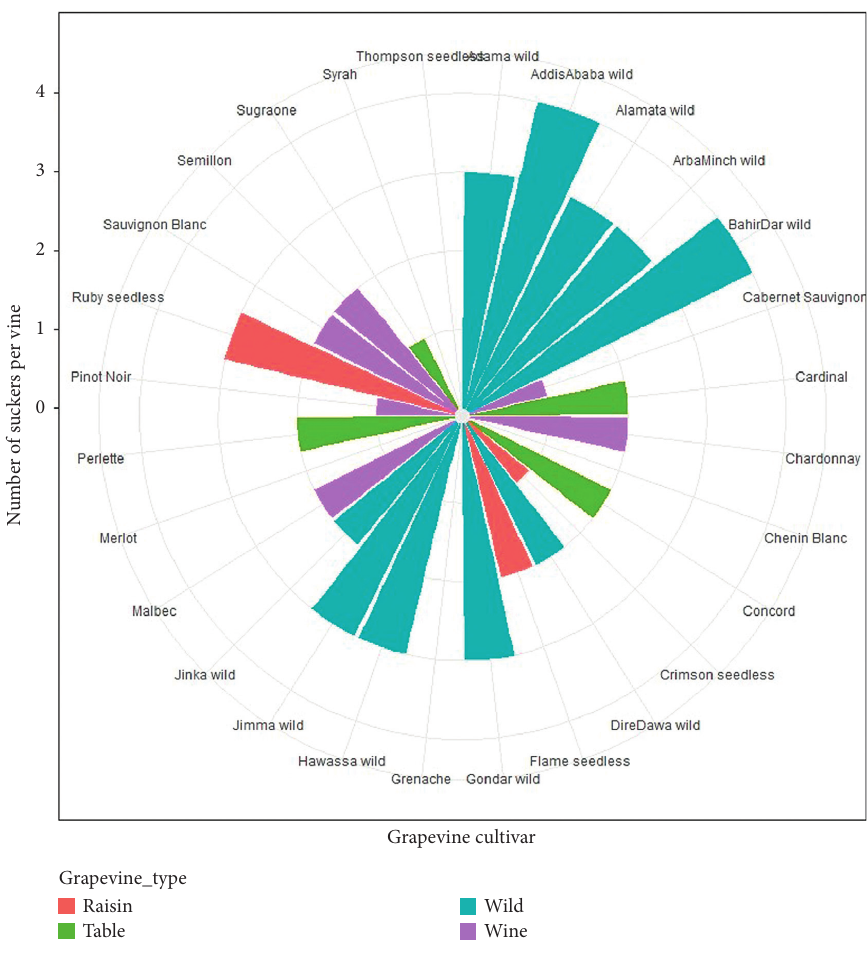
Figure 13: Number of grapevine suckers in different cultivars and grapevine types. Table 3: The main effect of research site locations on grapevine trunk diameter, root length, number of flower clusters per vine, and number of suckers per